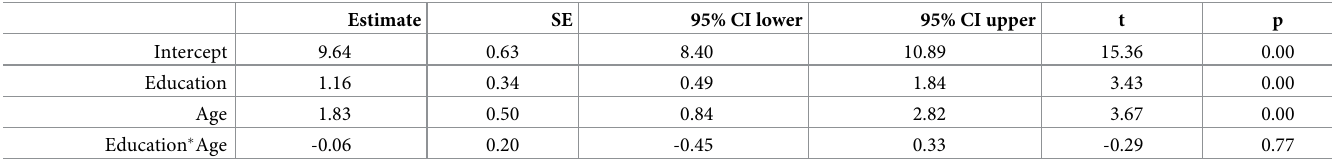
Table 2. Output for regression: Lister-Level � Education + Age + Education � Age. The predictors are continuous and de-meaned.